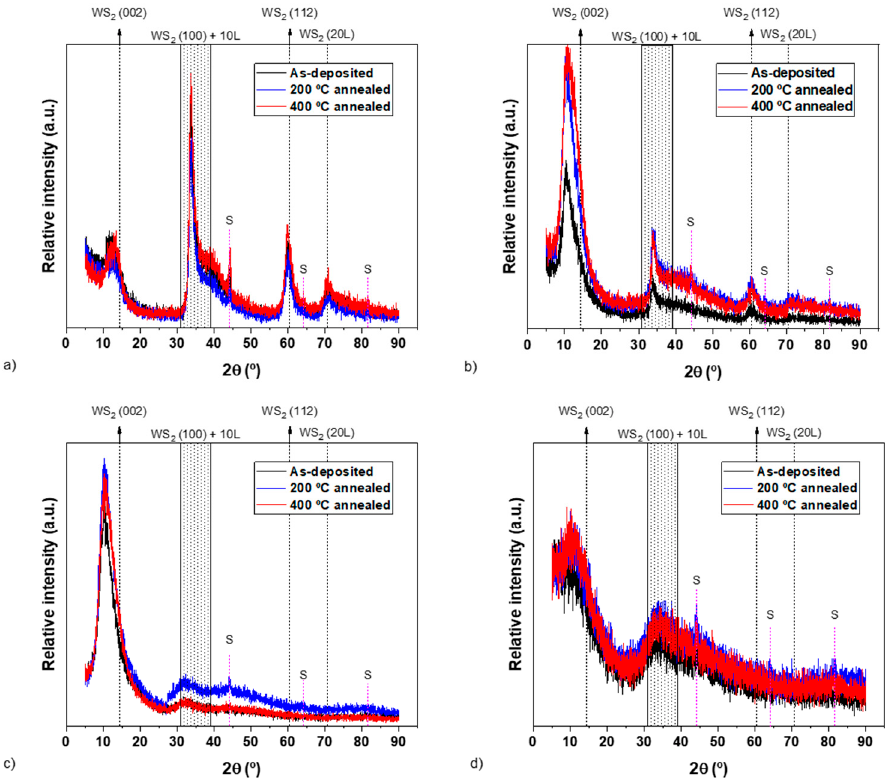
Figure 3. X-ray diffraction patterns of the as-deposited and annealed coatings (WS 2 ICCD card: 087-2417)—( a ) WS x , ( b ) WSN5, ( c ) WSN12.5, ( d ) WSN20.